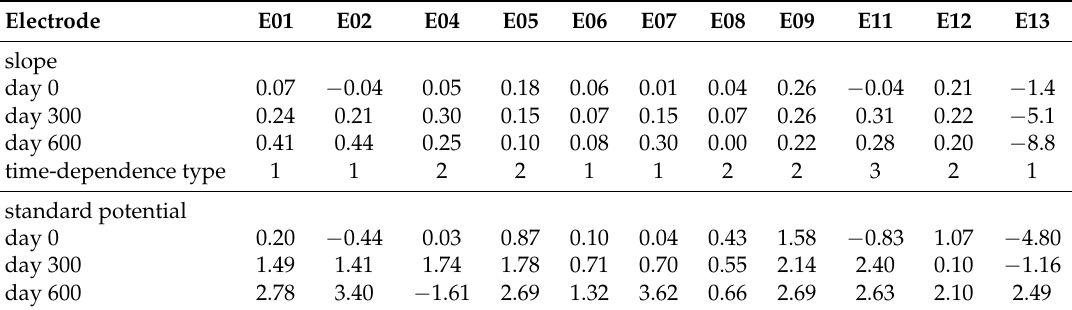
Table 6. Approximated values of the hysteresis on the indicated days (in